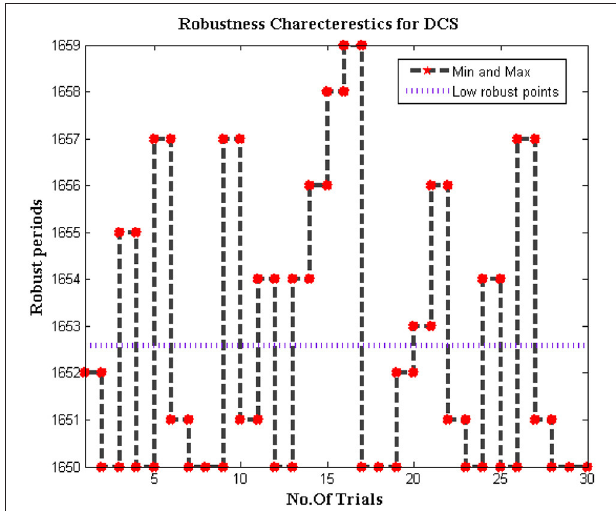
FIGURE 10 | Low robust points of